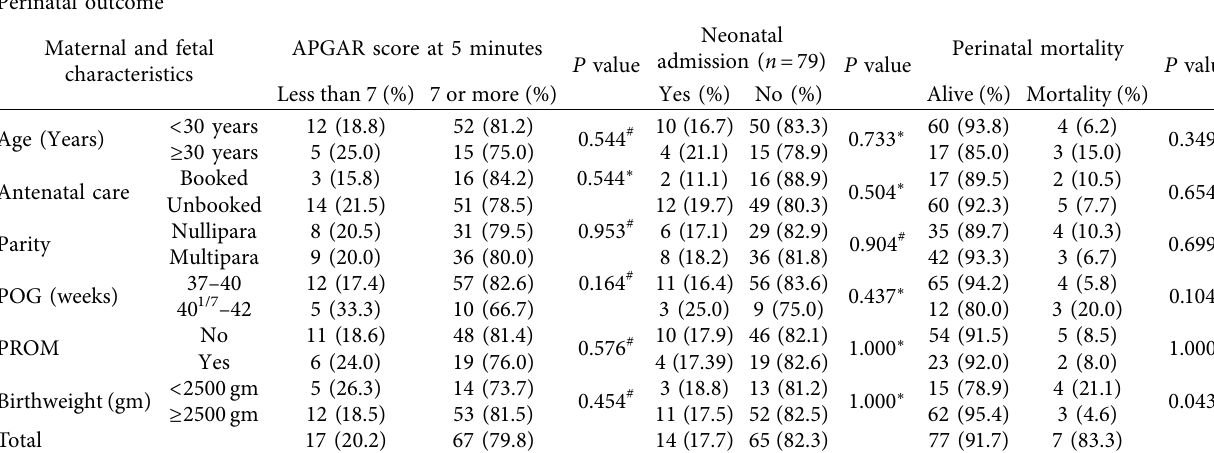
Table 5: Association of maternal fetal characteristics with perinatal